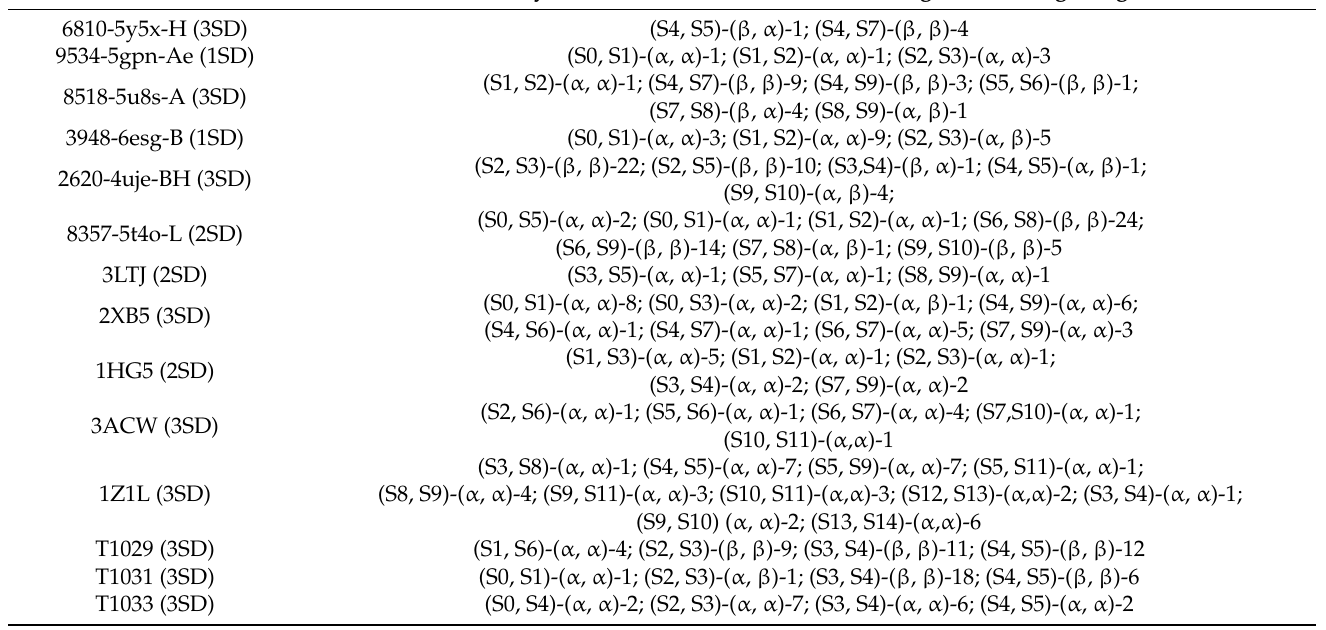
Table 1. Secondary structure contact pairs derived from amino acid contact prediction. Amino acid contact pairs were obtained using MULTICOM [40,41] or RaptorX [42] (see details in Methods). a The ID of a test case involving a cryo-EM density map is labeled as EMDB ID-PDB ID-chain ID. The ID of a case involving a simulated density map is labeled using either a PDB ID or a CASP target ID. The threshold of p-values (standard deviations (SD)) used for selection of significant long-range pairs is indicated. b Secondary structure contact pairs are labeled using the IDs of sequence segments predicted using JPred [30], the type of secondary structure indicated as either α or β , and the number of significant long-range amino acid pairs that are mapped on the secondary structure